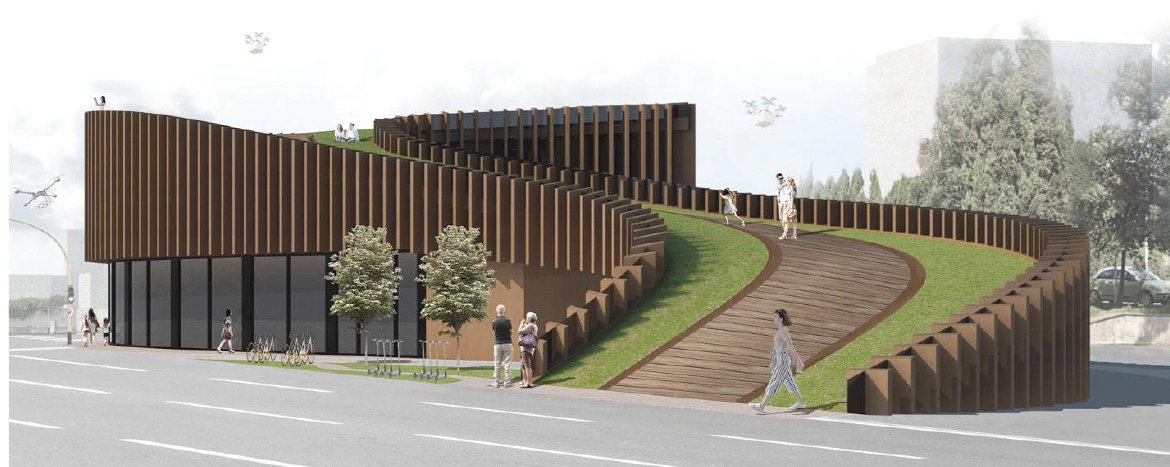
Figure 10 Carla Tufo, Florenze Smart City, Florence School of Architecture,